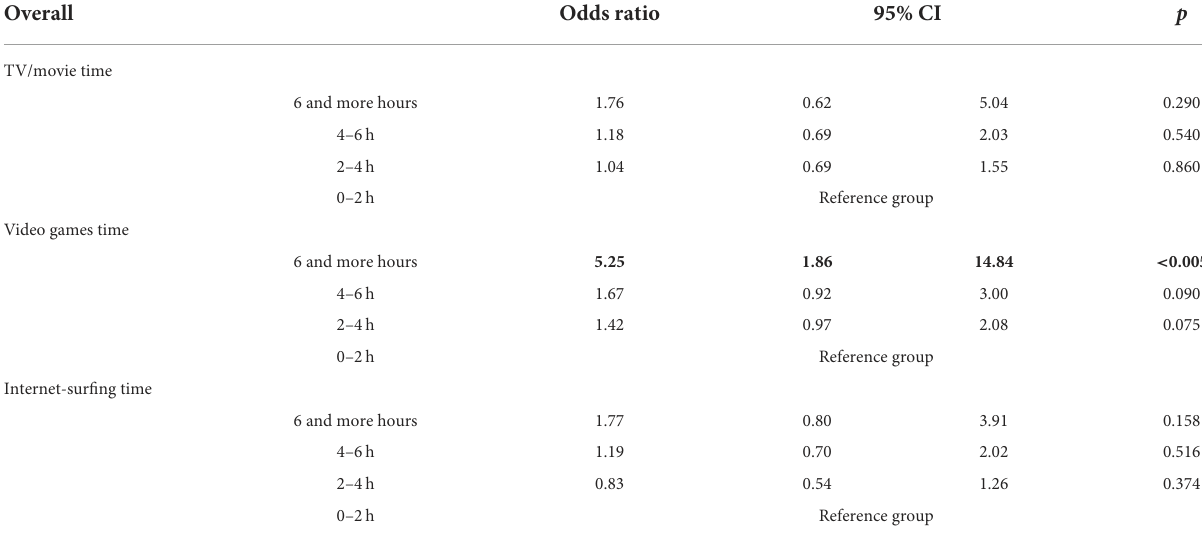
TABLE 2 Association between different types of sedentary-based behaviors and anxiety symptoms in the overall sample. Overall Odds ratio 95% CI p TV/movie time 6 and more